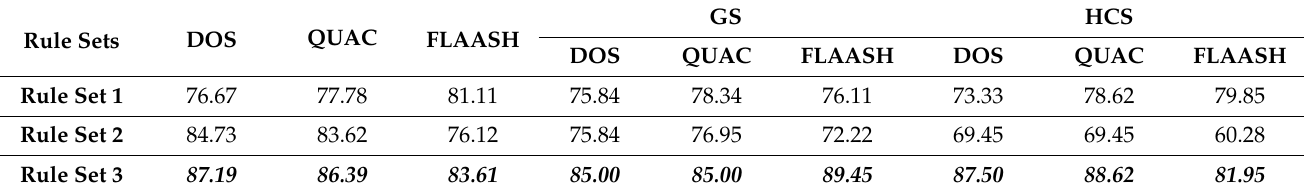
Table 6. Comparative performance of pansharpened and non-pansharpened subsets according to each rule set using the average overall accuracy across both study areas. Values of the best performing rule sets in each processing subset are emboldened and